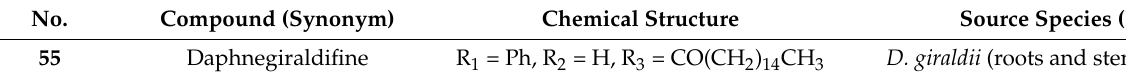
Figure 3. Structures of daphnetoxins ( 55 – 83 ). Table 2. Structures and sources of daphnetoxins ( 55 – 83